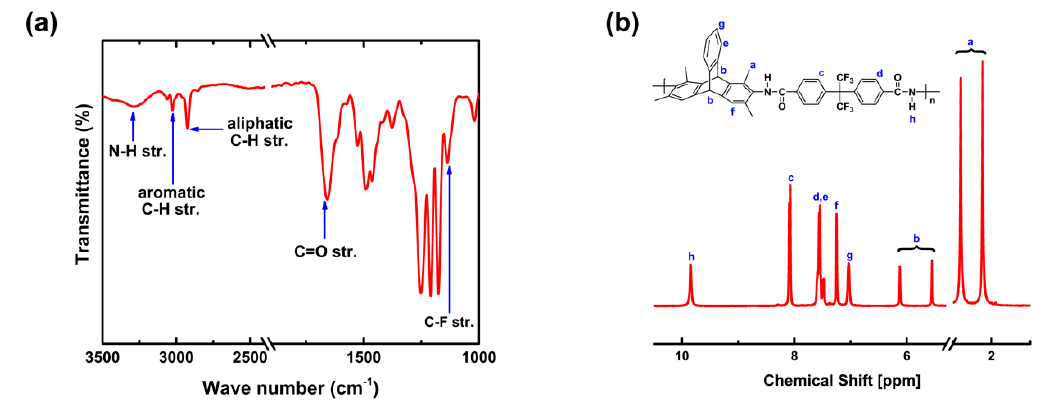
Figure 2. ( a ) FTIR and ( b ) 1 H NMR spectra of 6FBBA-TMDAT polyamide.